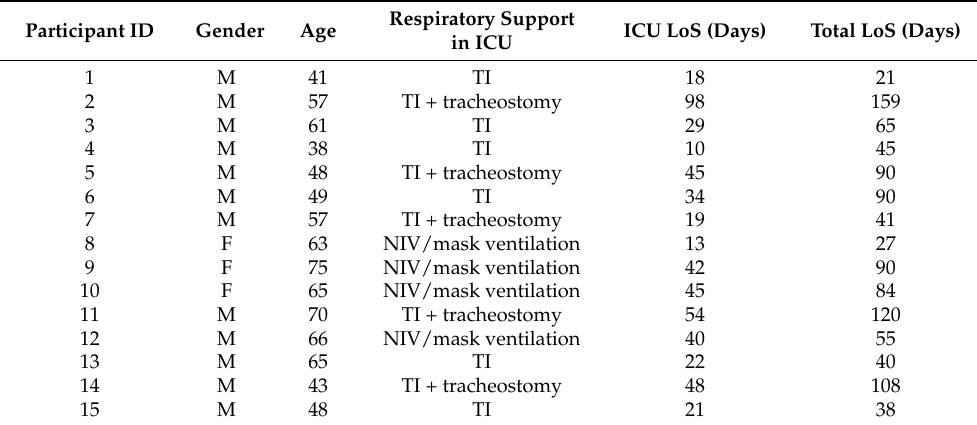
Table 2. Participants’ characteristics and length of stay (LoS).